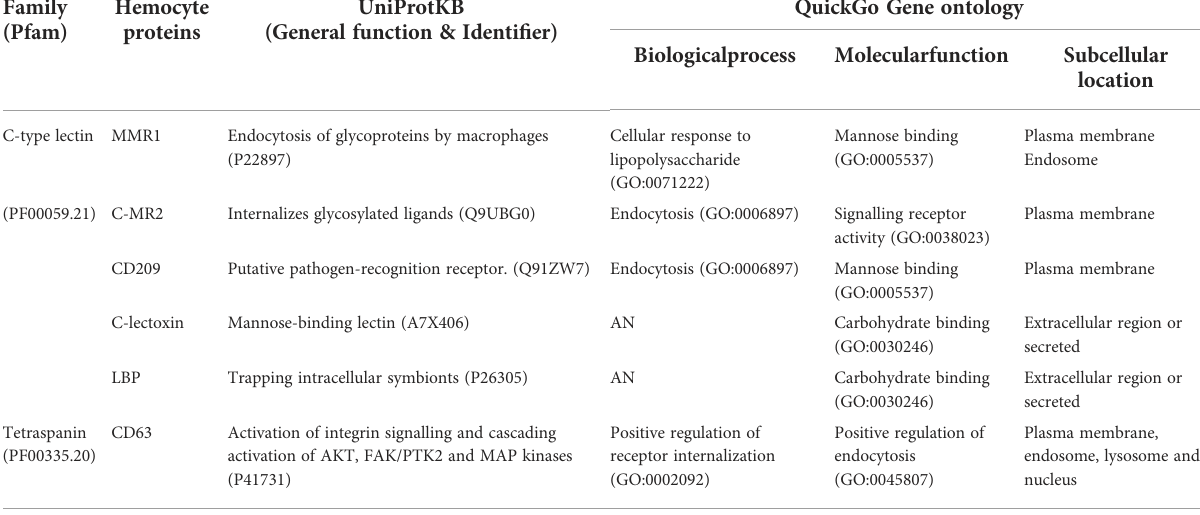
TABLE 1 Putative functions annotated for hemocyte proteins involved in immune-related functions.